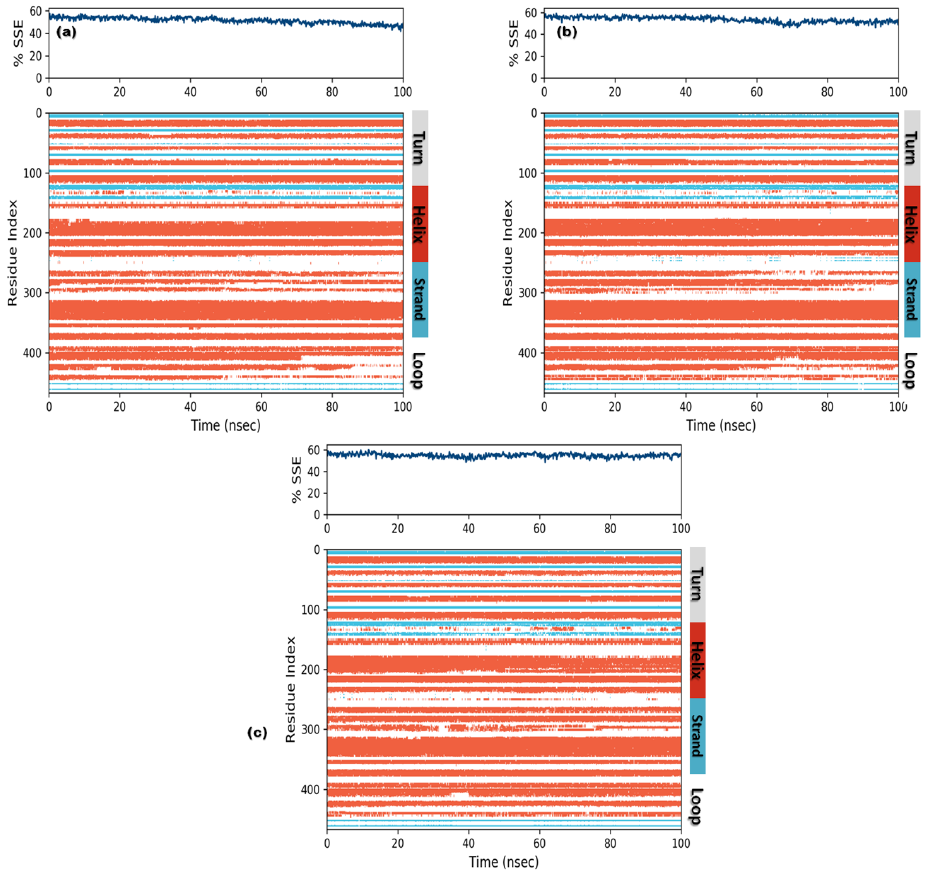
Figure 8. Secondary structures element composition frames for each trajectory (upper graph) and each residual SSE (lower graph) during the course of MD simulations for 3 hits (( a ) secoisolariciresinol, ( b ) syringaresinol and ( c ) cleomiscosin A).